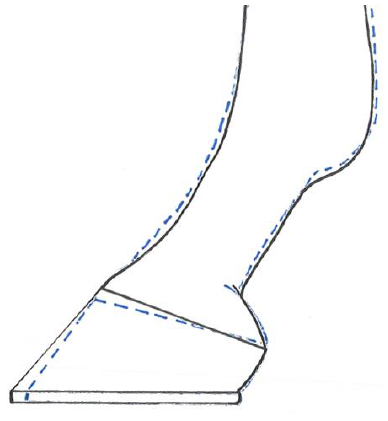
Figure 3. Pre-trimming (solid black line) and post trimming (blue dotted line); the solid line also represents the increased vertical orientation observed post-shoeing/trimming. Note the more upright angle of both the heel angle and DHW angle, and the shortening of the toe.